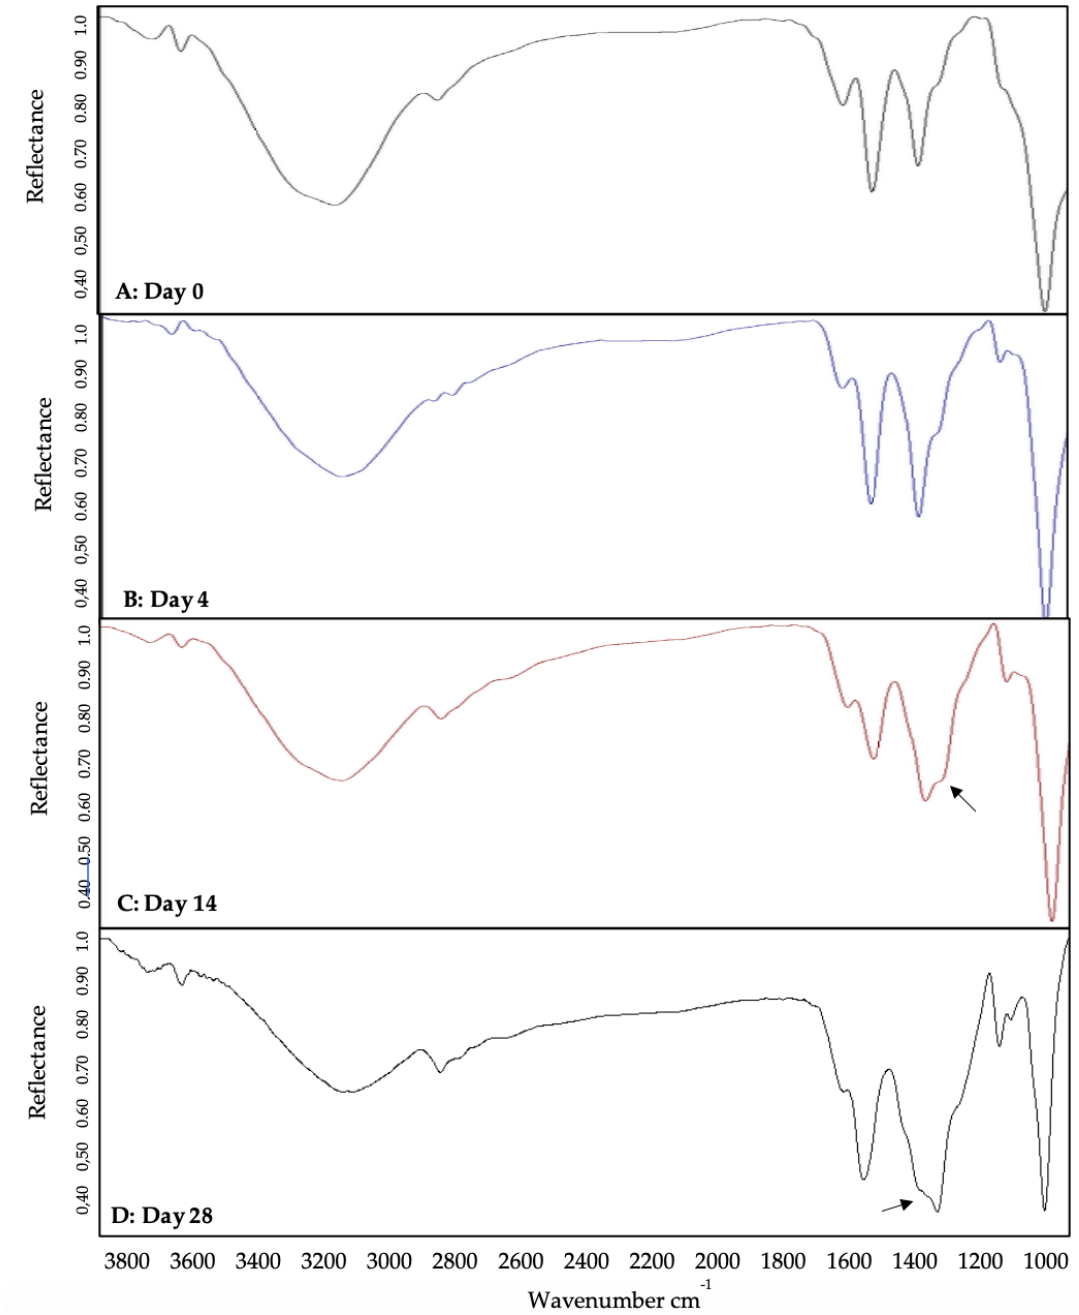
Figure 3. BMP-2-QDot ® s stability analyzed using FTIR spectroscopy. On day 0 and day 4, the BMP-2-QDot ® s conjugate is still stable ( A , B ). However, by days 14 and 28, the conjugation is falling apart as depicted by curve shifts and shoulder formation indicated by the arrow ( C , D ).